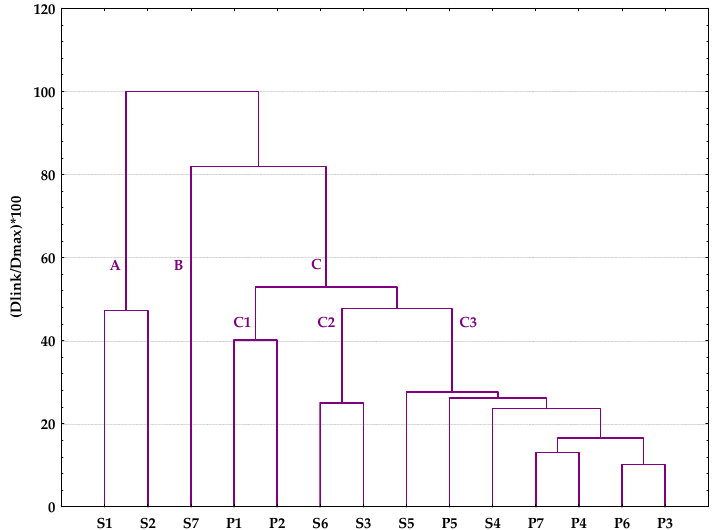
Figure 7. Dendrogram obtained by the cluster analysis based on the sensory assessment of 14 plum spirits.